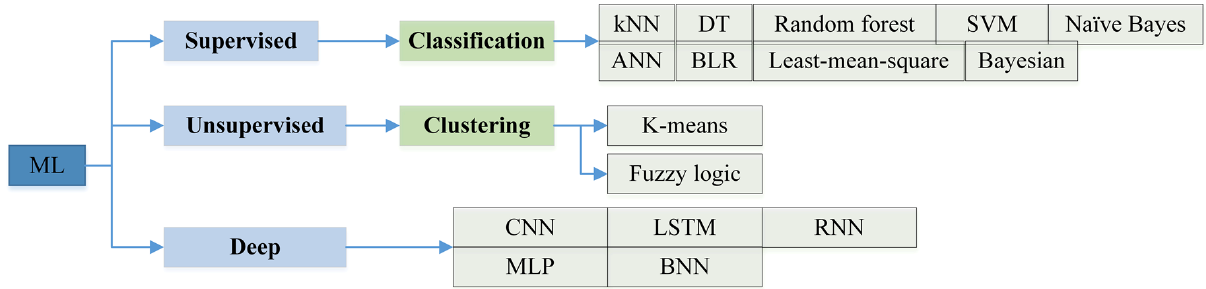
Figure 6. Classification of ML algorithms used in the security of WSNs.